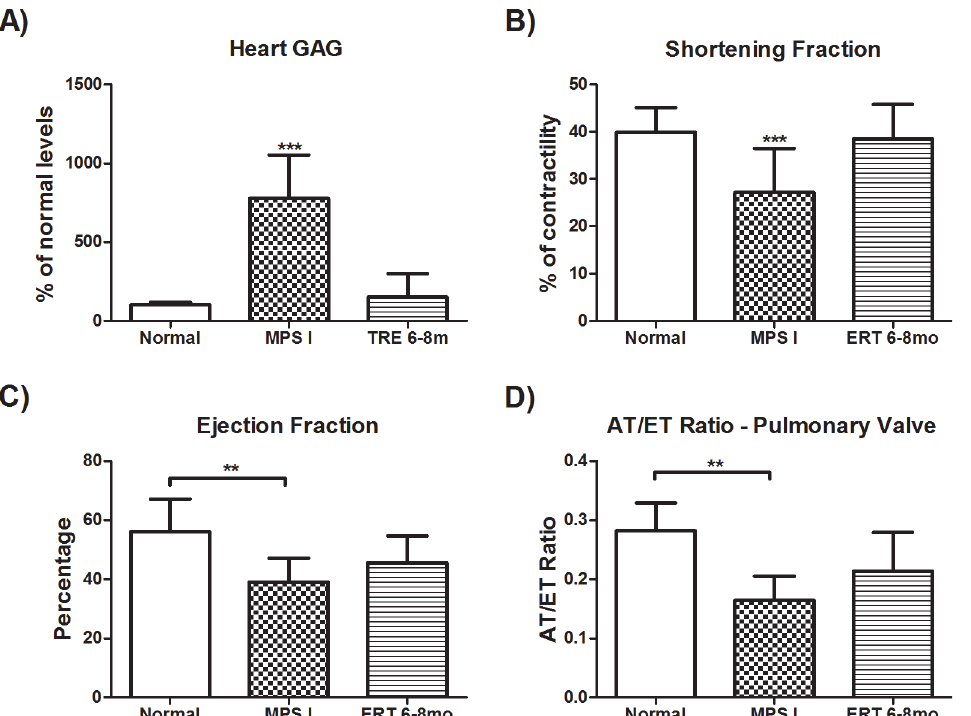
Fig 2. Heart function. A) GAG storage in hearts from 8-month old normal (n = 3), MPS I (n = 5) and MPS I mice treated with ERT from 6 to 8 months (ERT 6 – 8mo, n = 10), 2 weeks after last injection. B-D: Echocardiography results from 8-month old normal (n = 6/8), MPS I (n = 6/10) and MPS I mice treated with ERT from 6 to 8 months (ERT 6 – 8mo, n = 10), 1 day after last injection. B) Ejection fraction, C) Shortening fraction D) Ratio between ejection and acceleration times measured at the pulmonary valve. *** P (cid:1) 0.001, ** P (cid:1) 0.006 ANOVA and Tukey post hoc